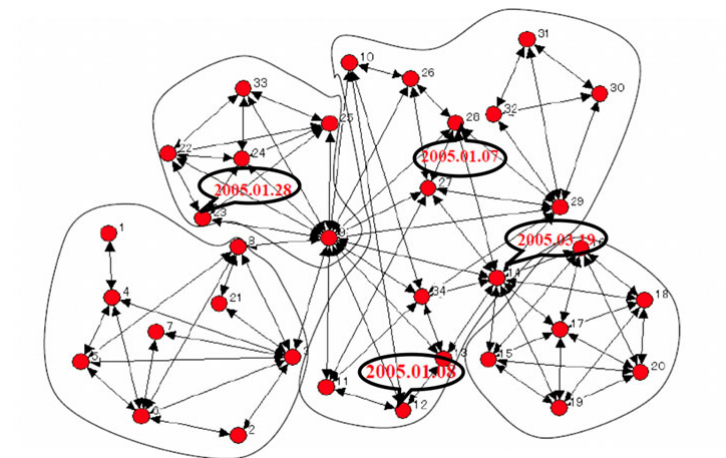
Figure 3. The date of typing and